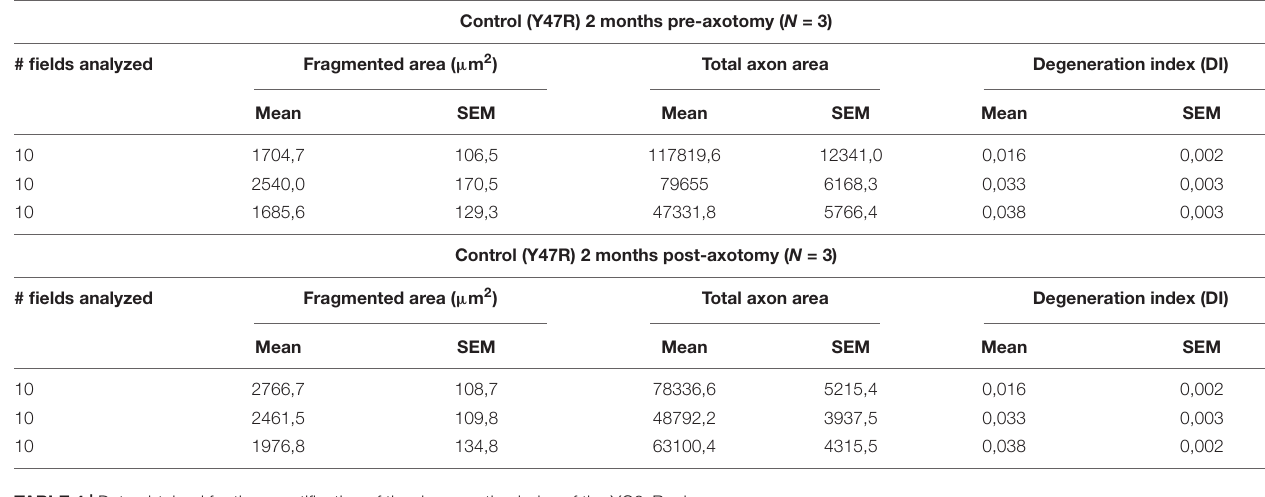
TABLE 4 | Data obtained for the quantification of the degeneration index of the YG8sR